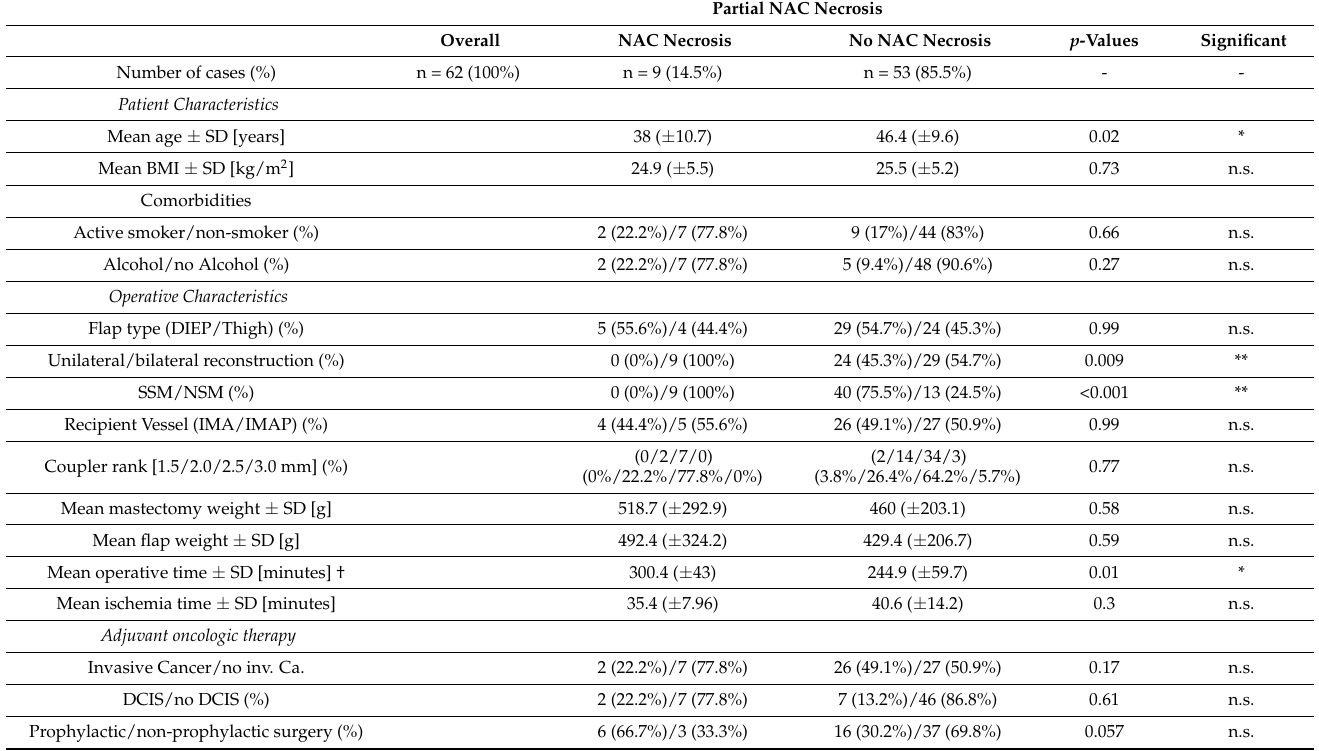
Table 4. Univariate analysis of risk factors between cases with and without partial NAC